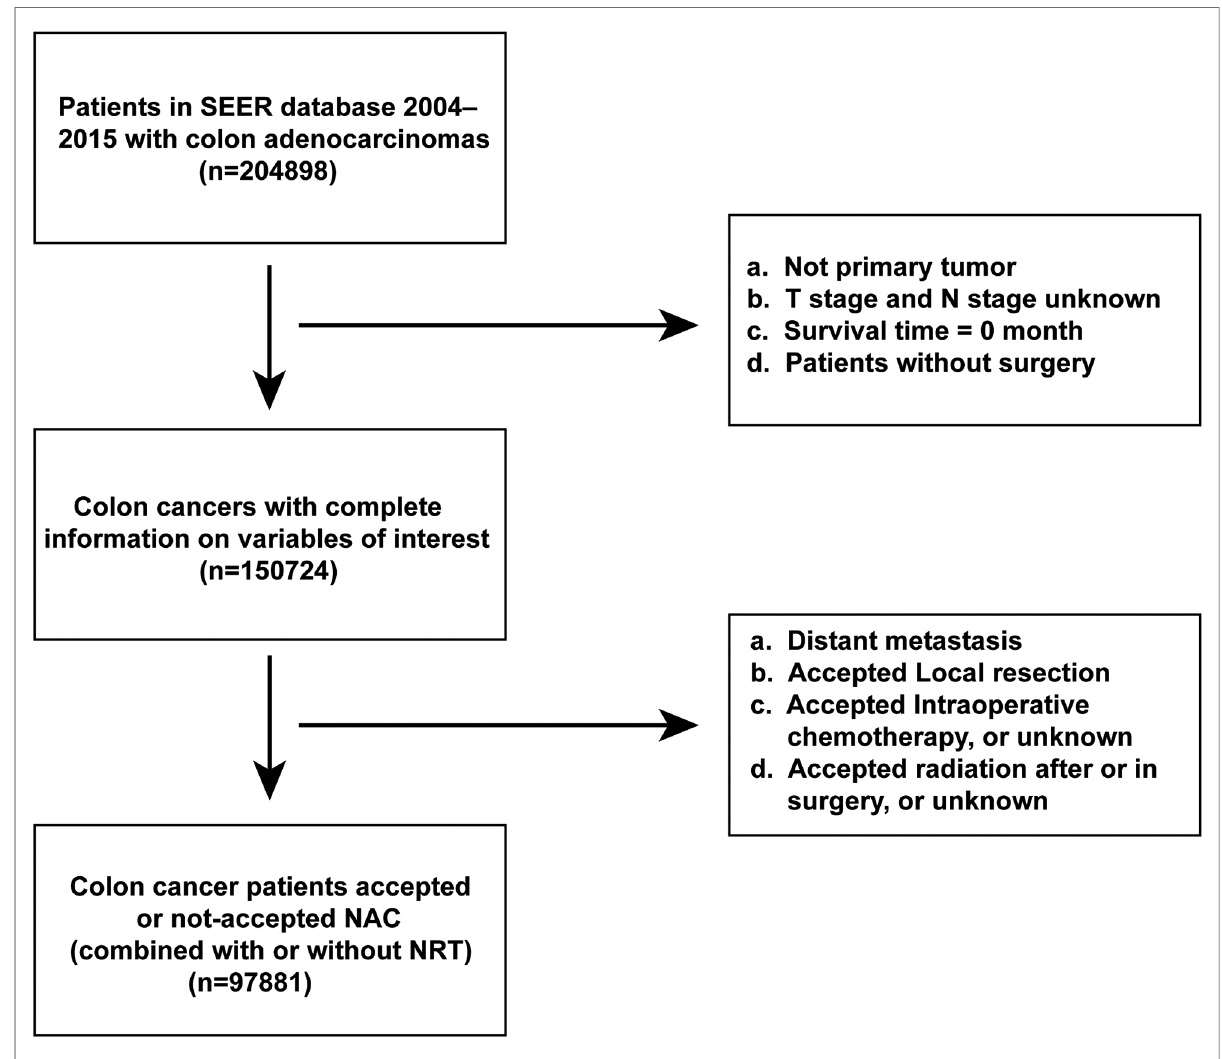
FIGURE 1 Flowchart of the patient selection